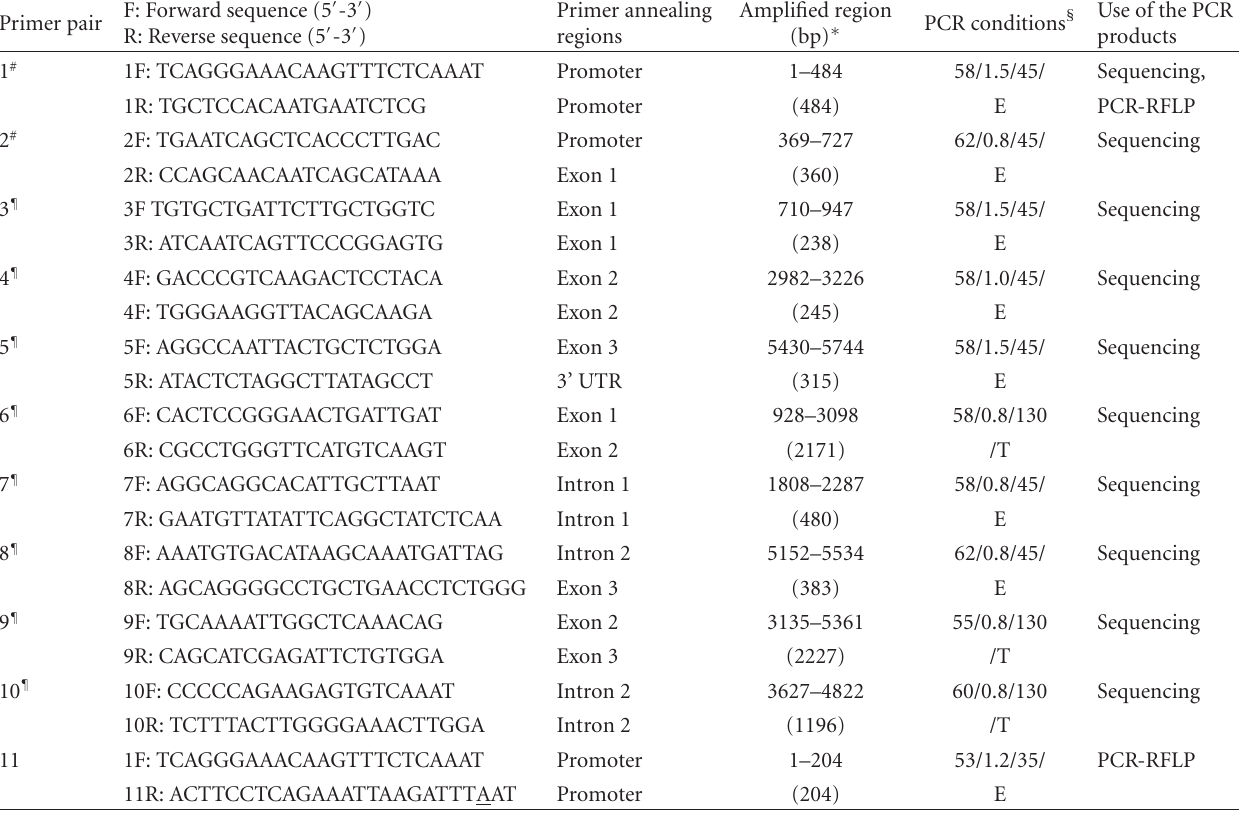
Table 2: Primers, PCR conditions, amplified regions, and use of the PCR products. F: Forward sequence (5 (cid:3) -3 (cid:3) ) Primer pair R: Reverse sequence (5 (cid:3) -3 (cid:3)